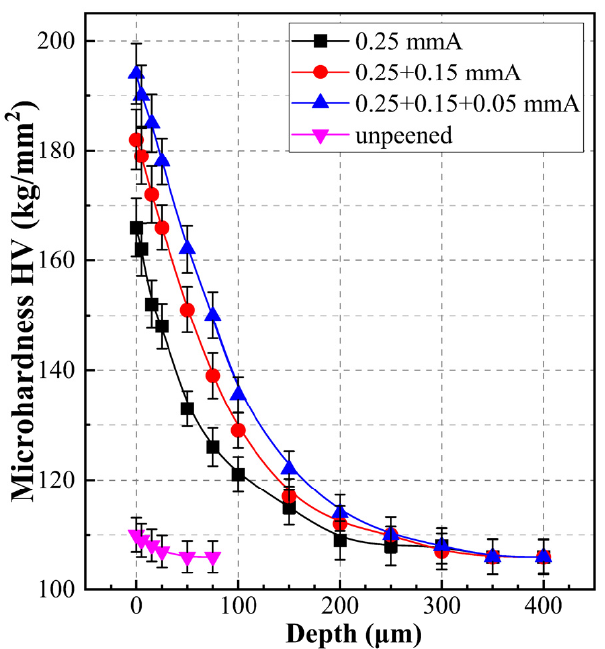
Figure 8. Microhardness − depth distribution of CNTs/Al − Mg − Si alloy composite treated by multiple shot peening.